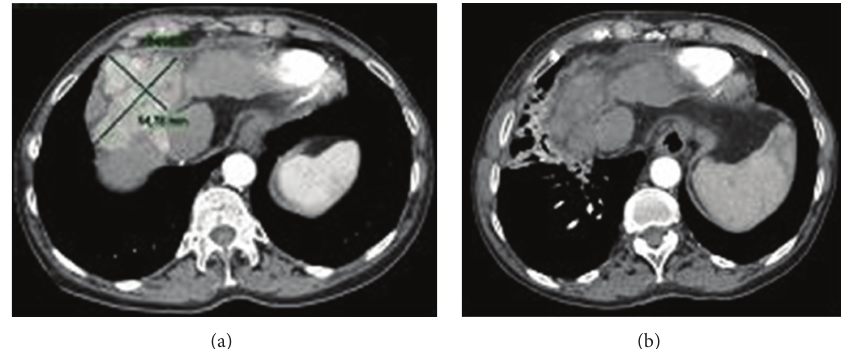
Figure 3: Abdominal computed tomography scans before and 6 months after HSRT show a complete disappearance of hypervascular arterial enhancement of primary